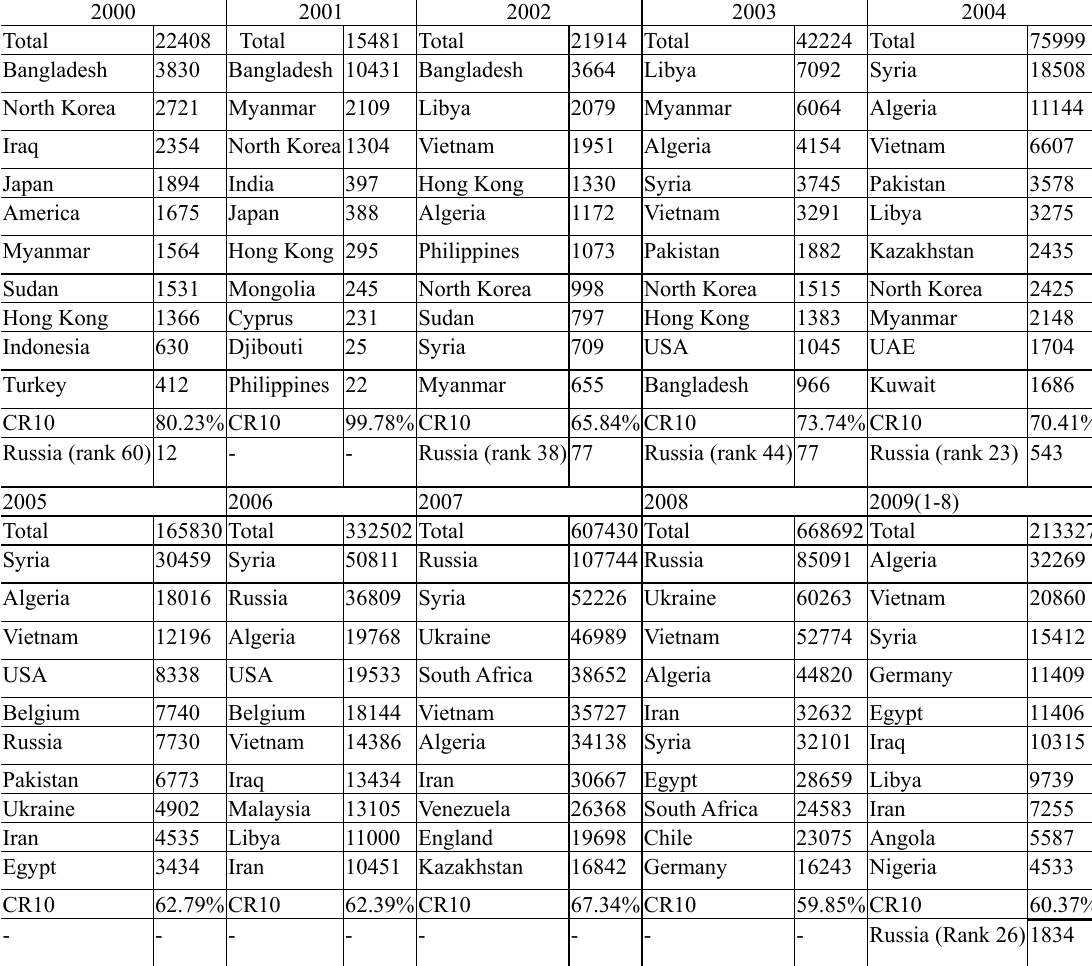
Table 2. Top ten export records by country from 2000–2009 and exports to Russia (unit: